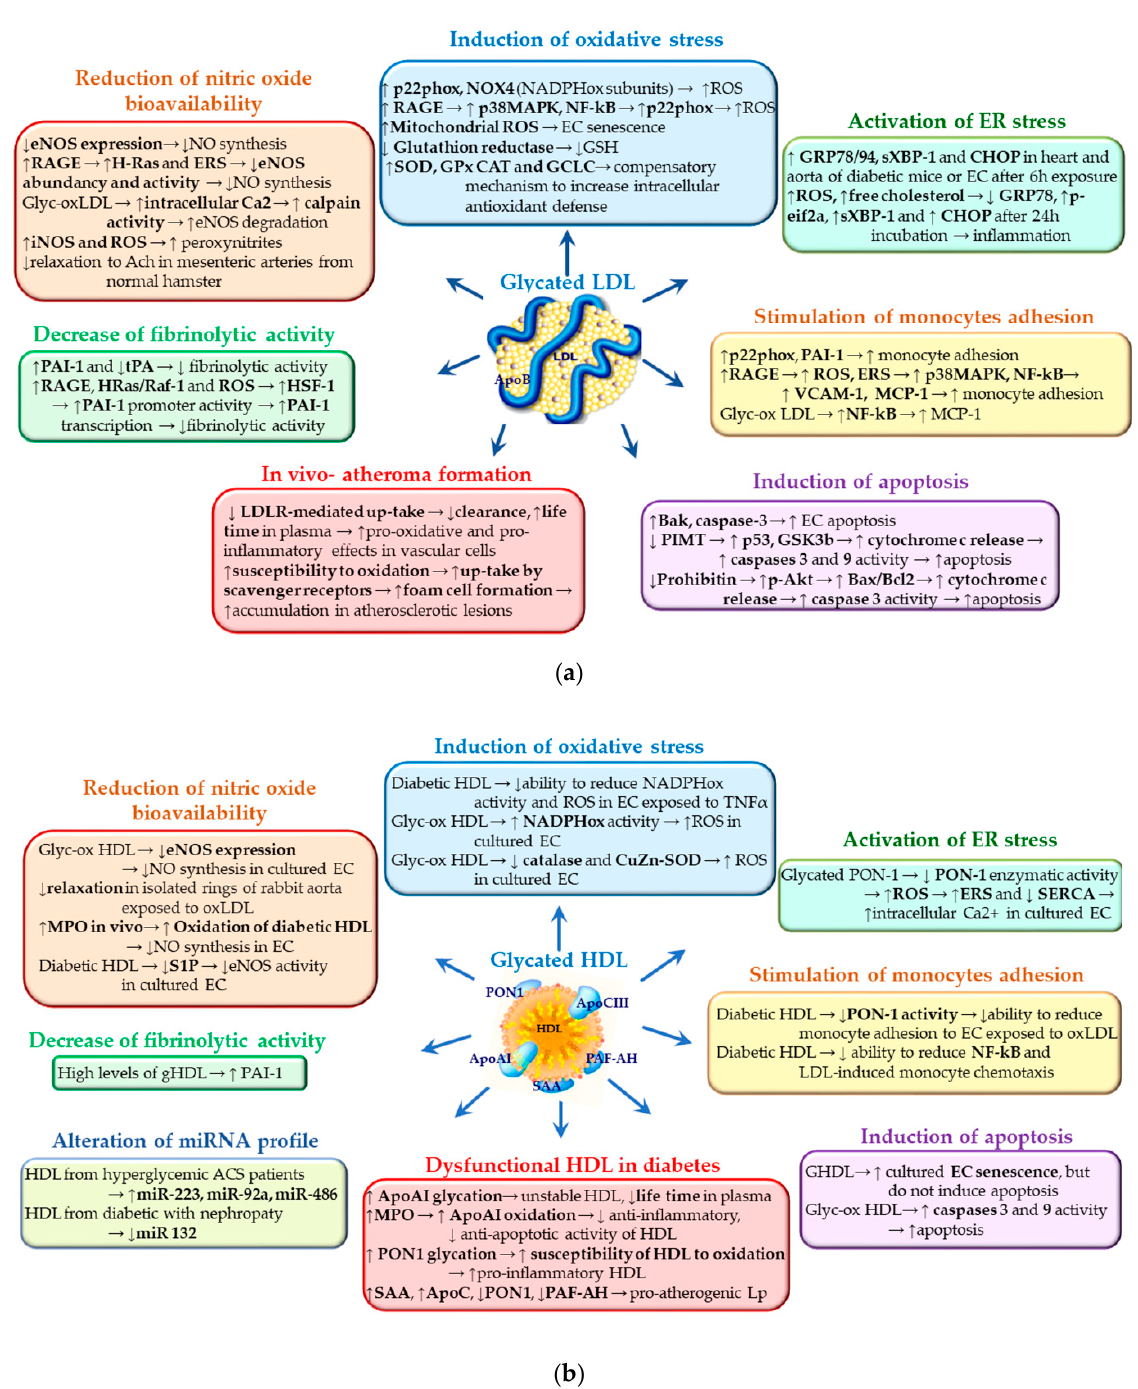
Figure 3. Molecular mechanisms of gLDL ( a ) or gHDL ( b ) contributing to endothelial cell dysfunction. The blue arrows indicate the detrimental actions of gLp in endothelial cells; the small black arrows indicate the specific molecular mechanisms by which gLp determine the dysfunction of endothelial cells as showed by experimental data.